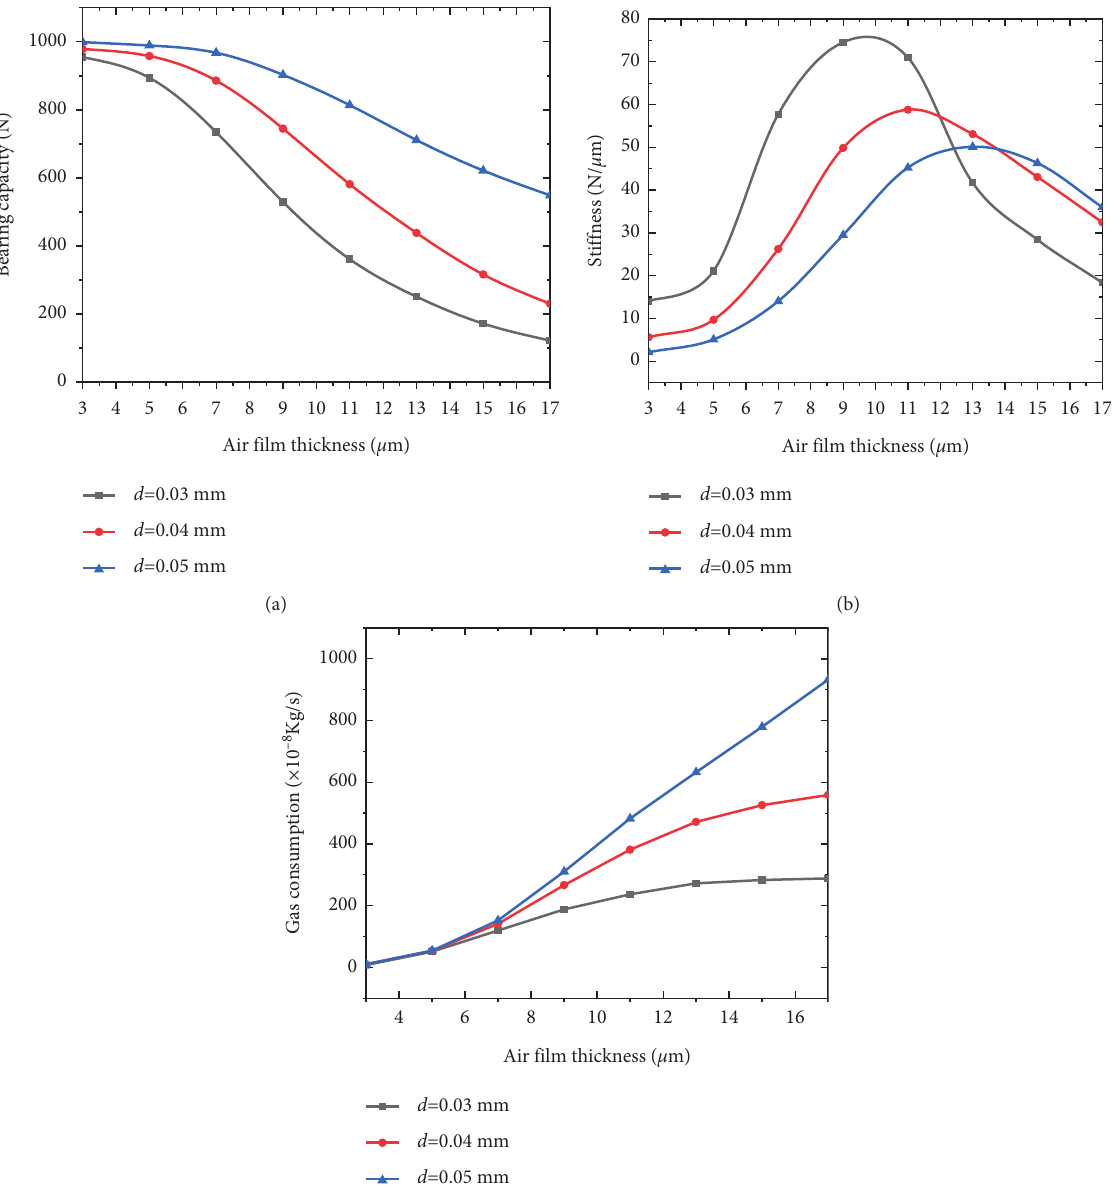
Figure 7: Effect of orifice diameter on bearing